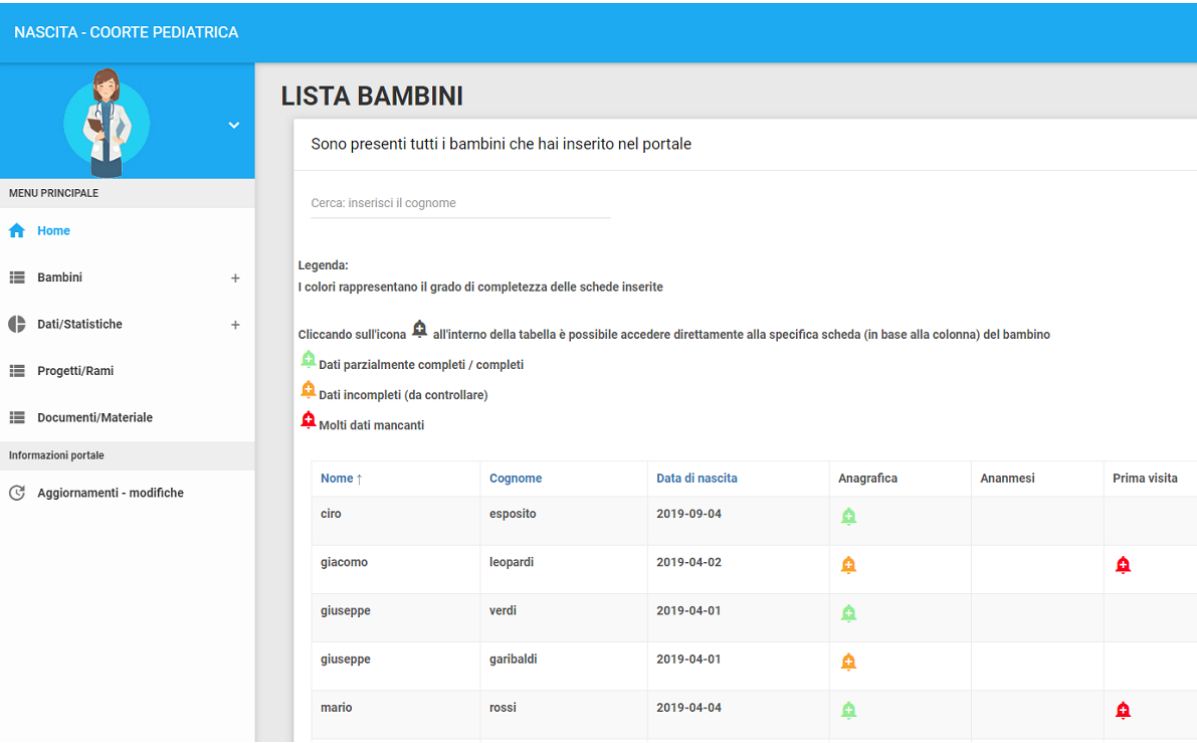
Figure 5. eCRF dashboard for checking completeness of data on the visits for individual